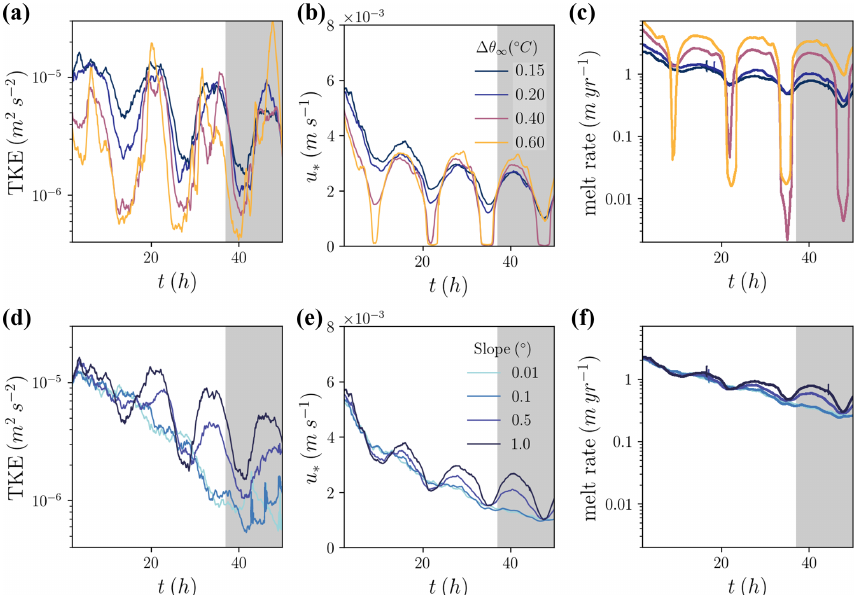
Figure 2. Time evolution of (a, d) domain-averaged, resolved turbulence kinetic energy (TKE), (b, e) melt rate, and (c, f) friction velocity for (a–c) thermal driving simulations and (d–f) variable slope simulations. The black curve represents the same simulation in all panels in this and subsequent figures. The analysis window, the last inertial period, is